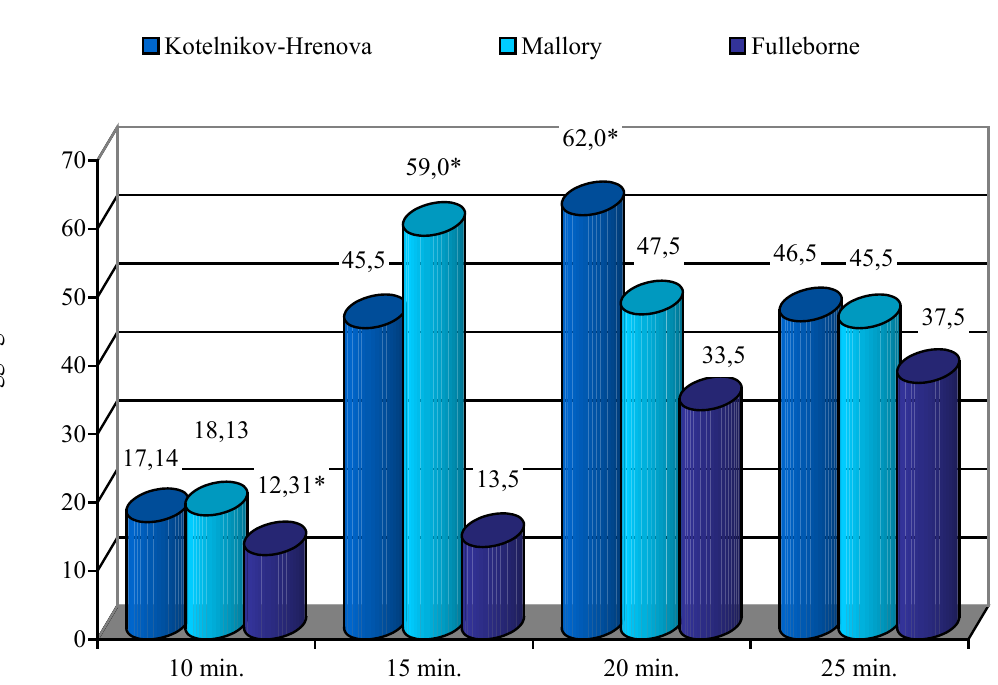
Fig. 1. Effectiveness of flotation methods for geese